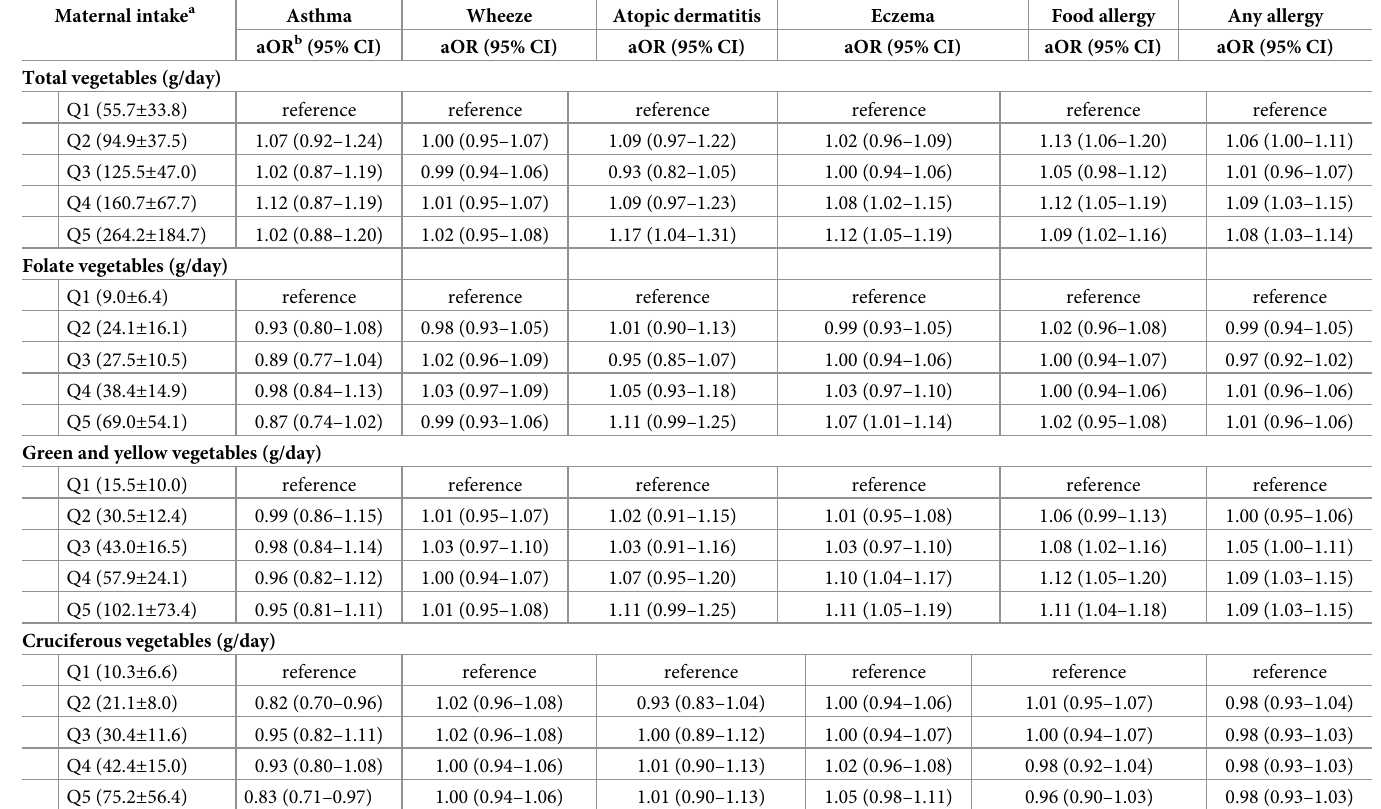
Table 2. Association between maternal vegetable intake and allergic disease in